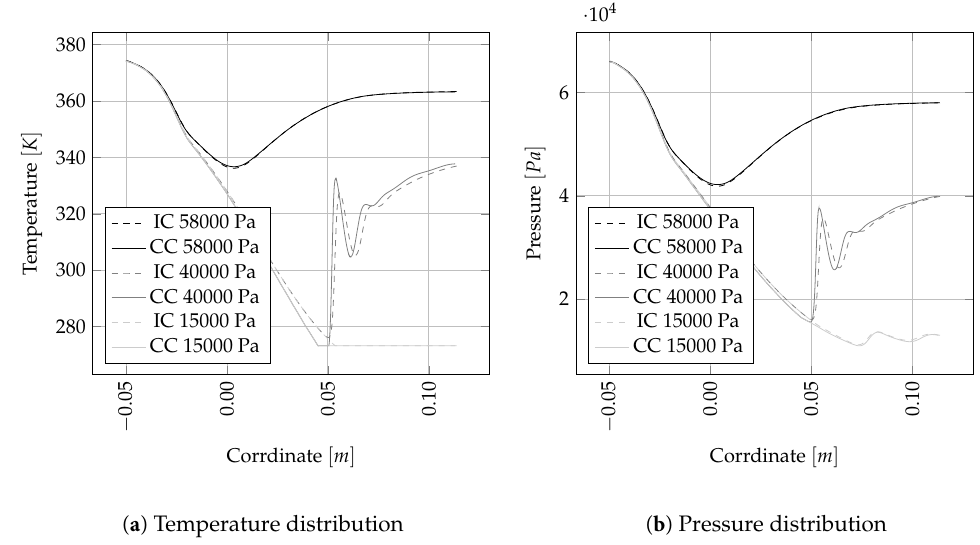
Figure 8. Allowing region 2 only. In-house code (IC) vs. commercial code (CC).